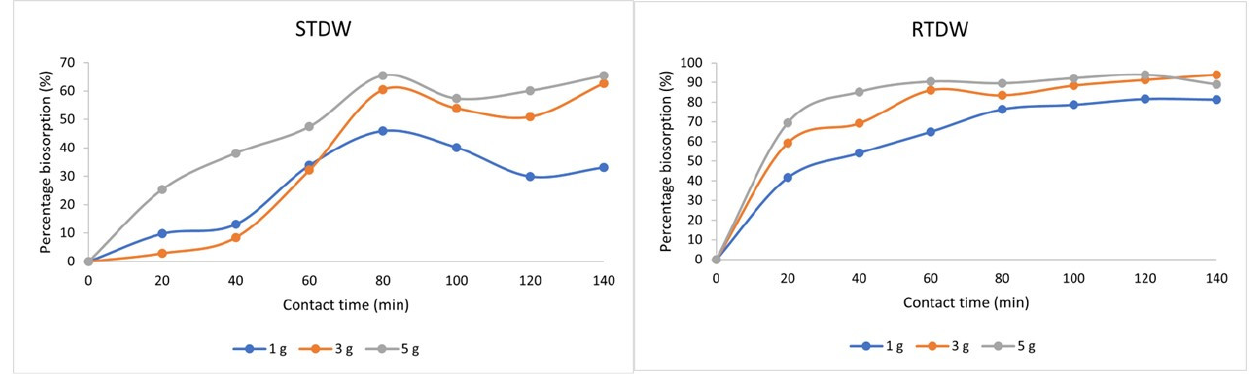
Figure 12. STDW and RTDW percentage biosorption onto activated dolomite against time. (Experimental conditions: C o STDW = 100 mg/L; C o RTDW = ~10.0 mg/L; absorbent dosage = 1.0 g, 3.0 g and 5.0 g per 100 mL, dolomite T = 700 °C, particle size > 1.0 mm, mixing rate = 100 rpm, T = 25 ± 1 °C).